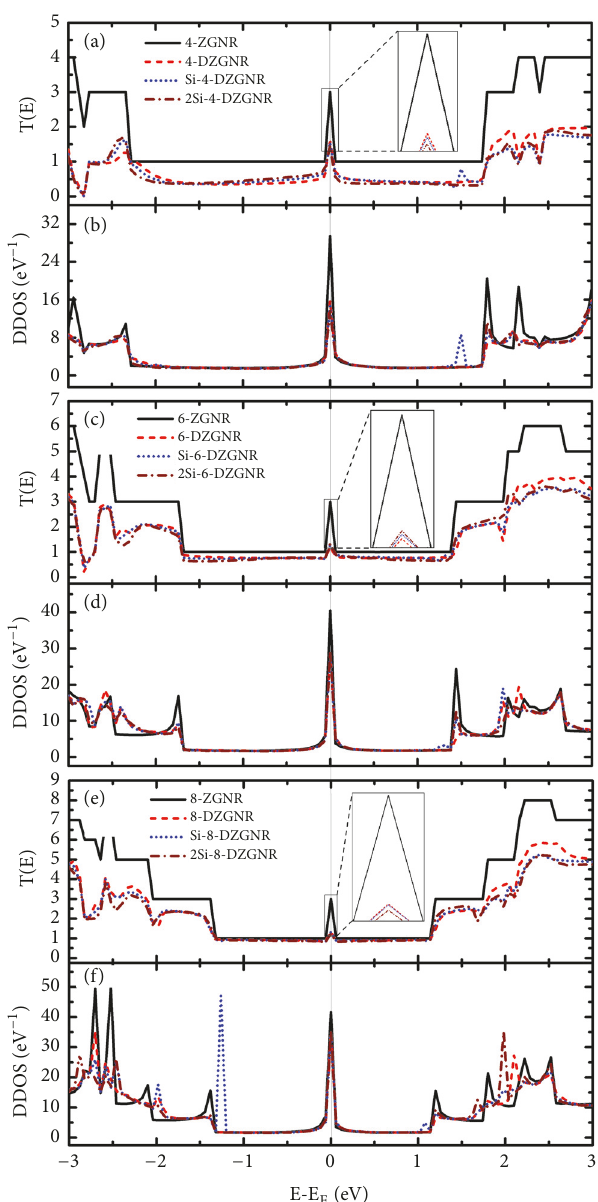
Figure 4: Transmission spectrum T(E)((a), (c), and (e)) and device density of states DDOS ((b), (d), and (f)) as a function of electron energy at zero bias voltage. The results are shown for four zigzag chains (a), six zigzag chains (c), and eight zigzag chains (e) the samples.